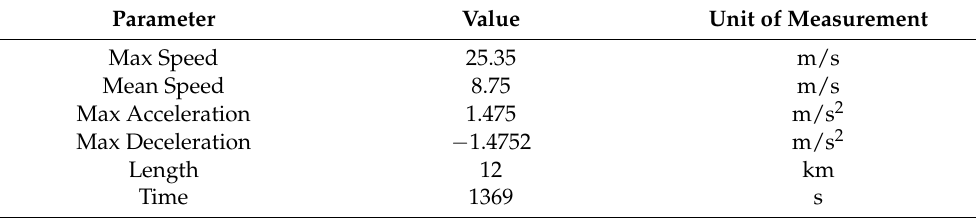
Table 6. Drive Cycle, EPA Urban Dynamometer Driving